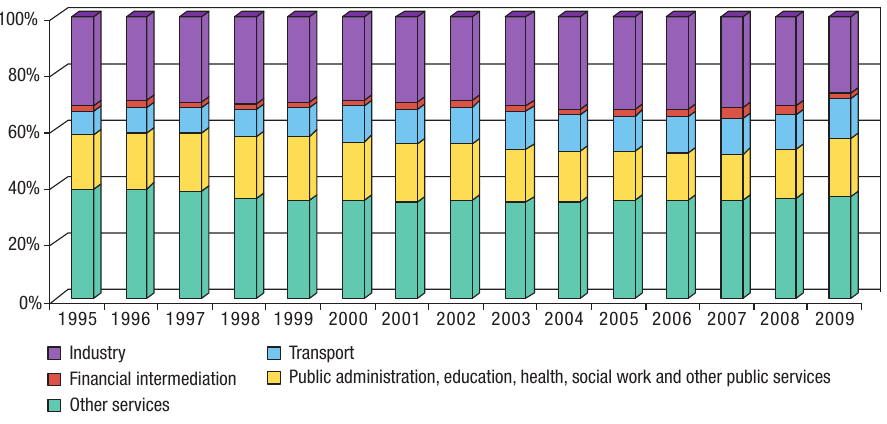
Fig. 2. Lithuanian GDP by type of economic activity, mill. EUR Source : Data from